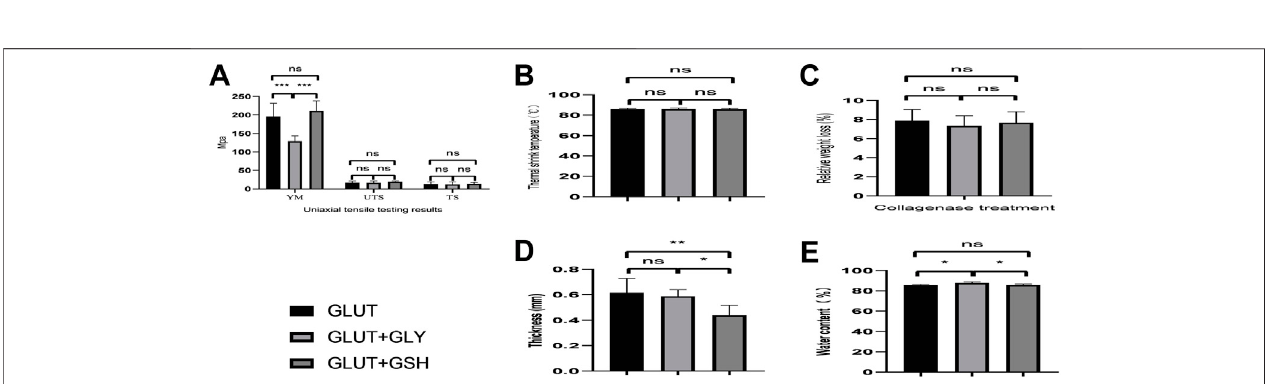
FIGURE 3 | Biomechanical properties of BP from GLUT-BP, GLUT + GSH, and GLUT + GLY. (A) is mechanical properties of BP. Use the Young ’ s modulus (YM), ultimatetensilestress(UTS)andtensilestress(TS)toevaluatethemechanicalpropertiesofBPs. (B) isthermalshrinkagetemperature, (C) istheBPs ’ relativeweightloss after collagenase treatment, (D,E) is thickness and water content of BPs from each group ( n = 10; p p < 0.05; pp p < 0.01; ppp p < 0.001; ns represents no signi fi cant difference).